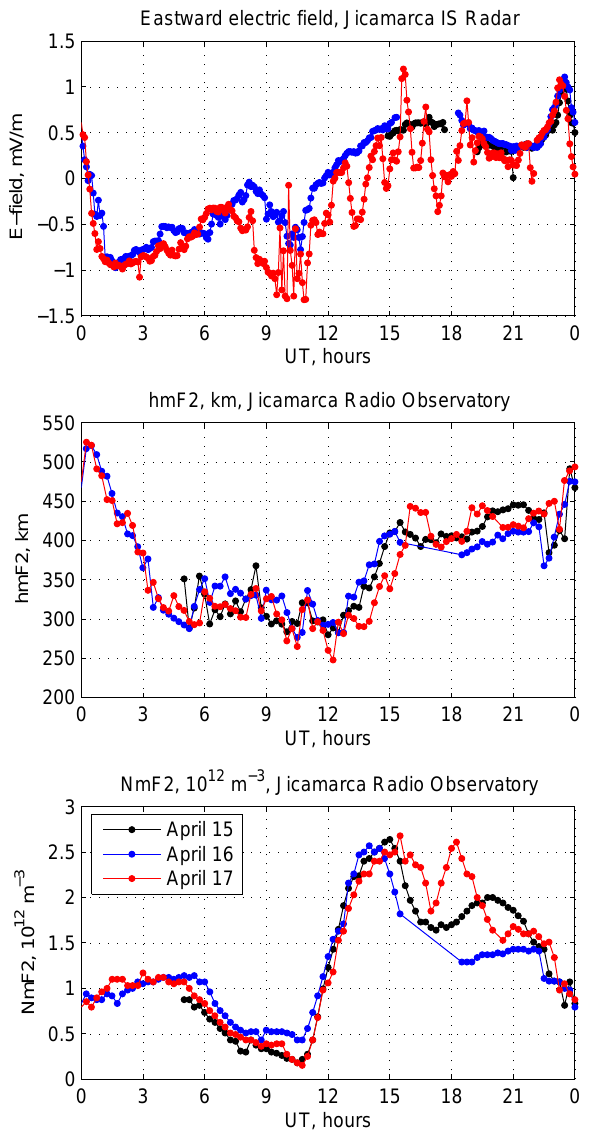
Fig. 12. Ionospheric parameters observed over Jicamarca on 15–17 April 2002: eastward electric field (top panel), height of the F-layer hm F2 (middle panel), and electron density at the peak of the F-layer Nm F2 (bottom